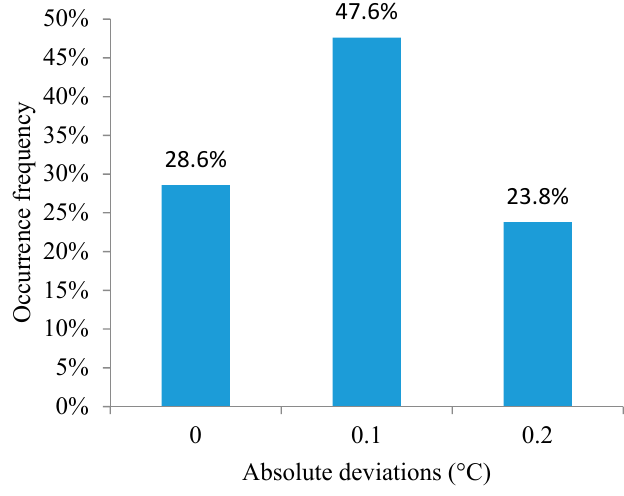
Figure 4. Occurrence frequencies for absolute deviation of the RR.